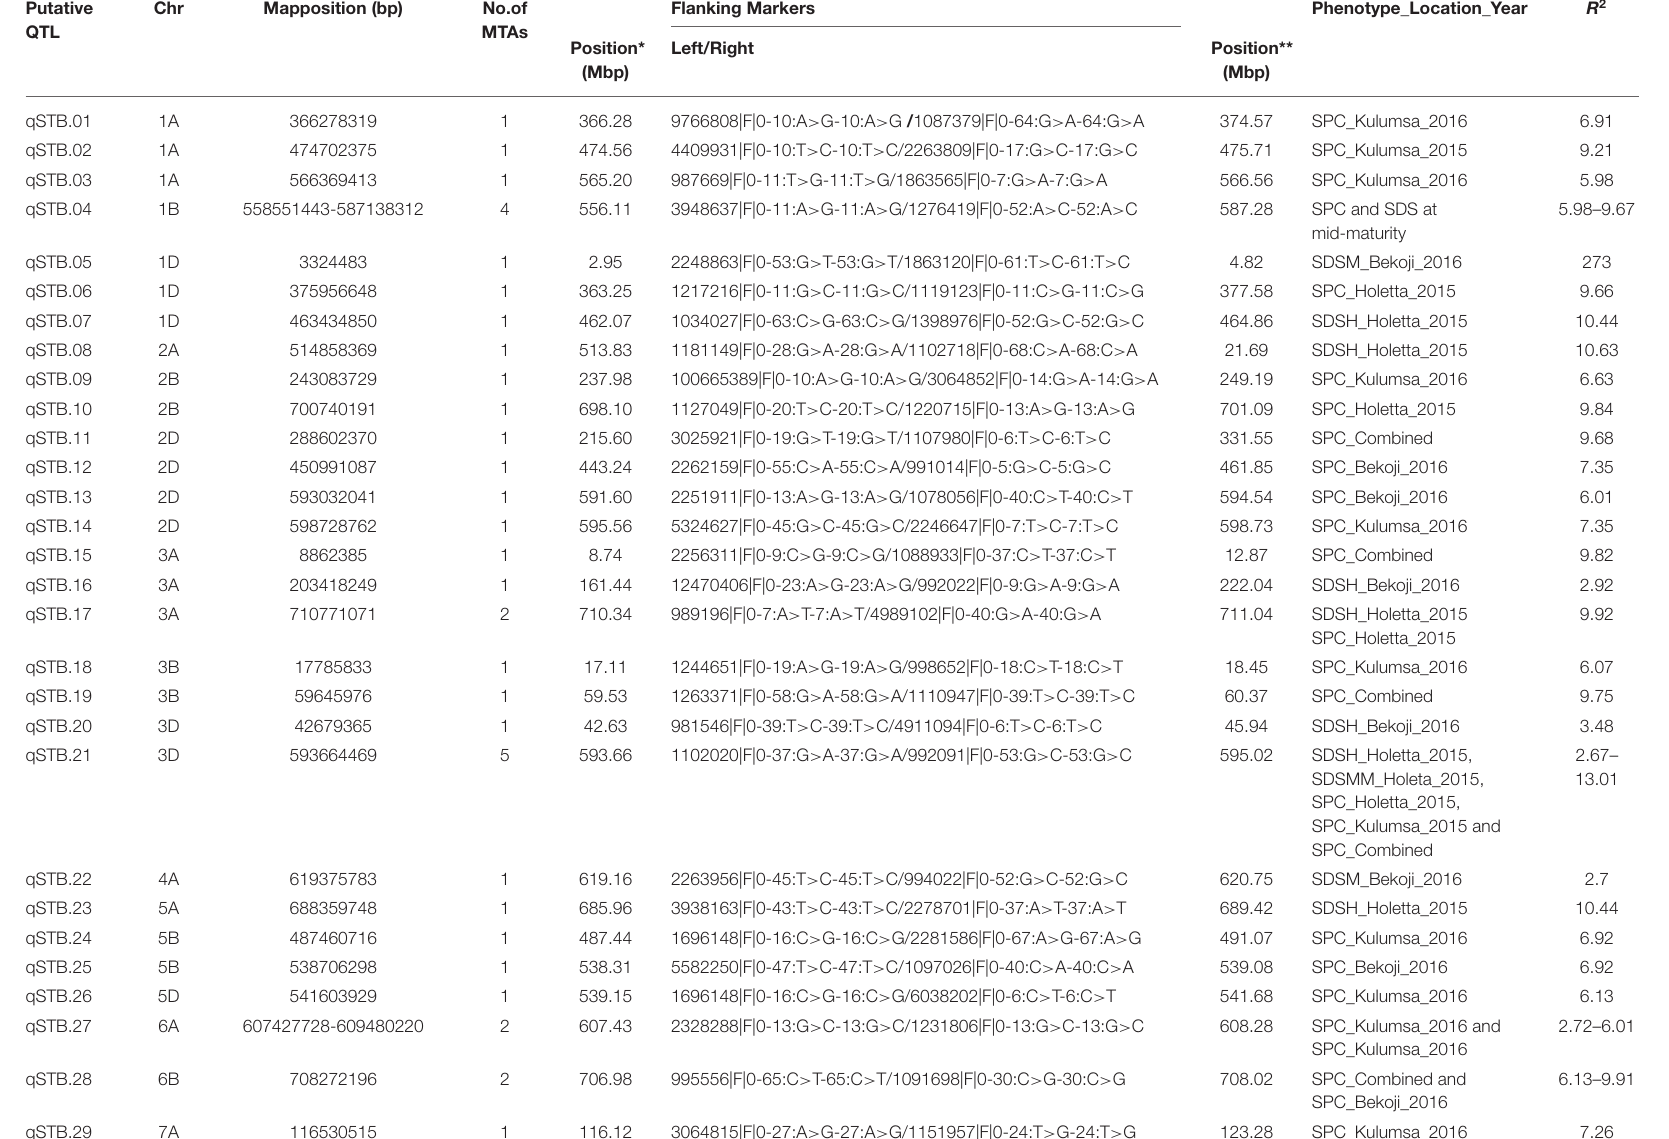
TABLE 8 | Summary of the putative QTLs identified across bread wheat chromosomes for STB